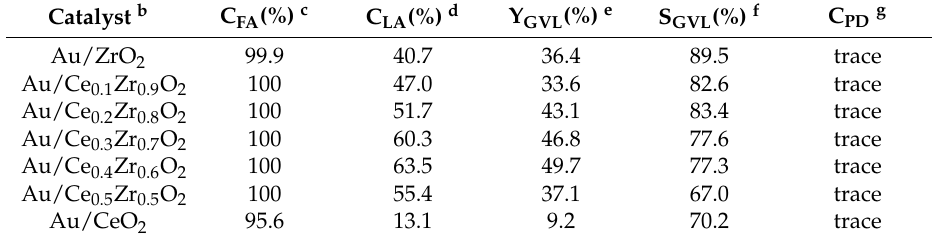
Table 2. The effect of doped Ce on the conversion of LA to GVL at 240 °C for 2 h a .